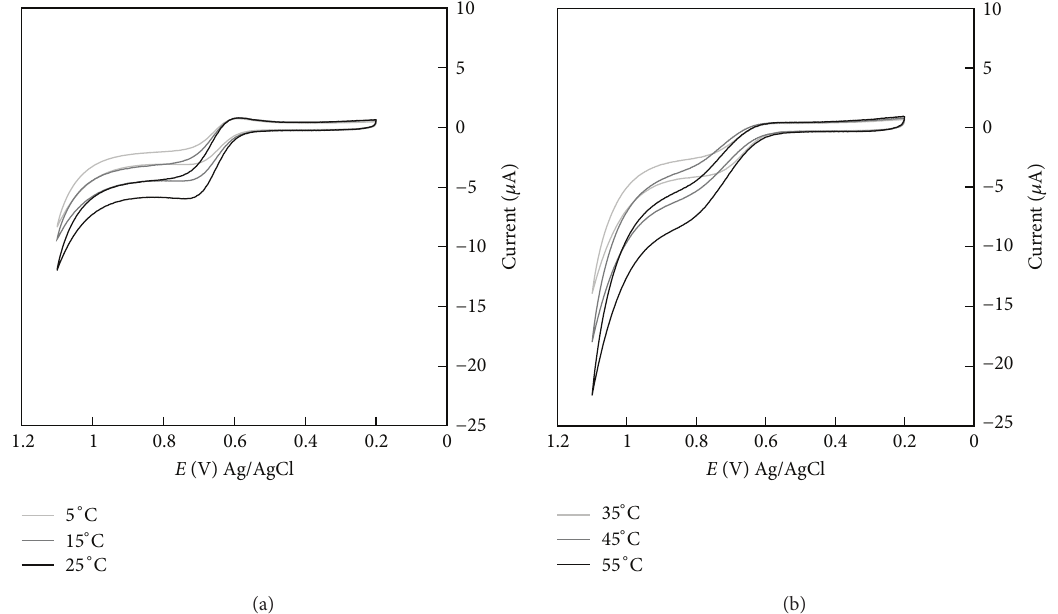
Figure 6: Cyclic voltammograms of poly(TEMPOMA- ran -NIPAAm) ( 1 󸀠 ) in 0.1M KCl aqueous solution at (a) 5, 15, and 25 ∘ C, (b) 35, 45, and 55 ∘ C.